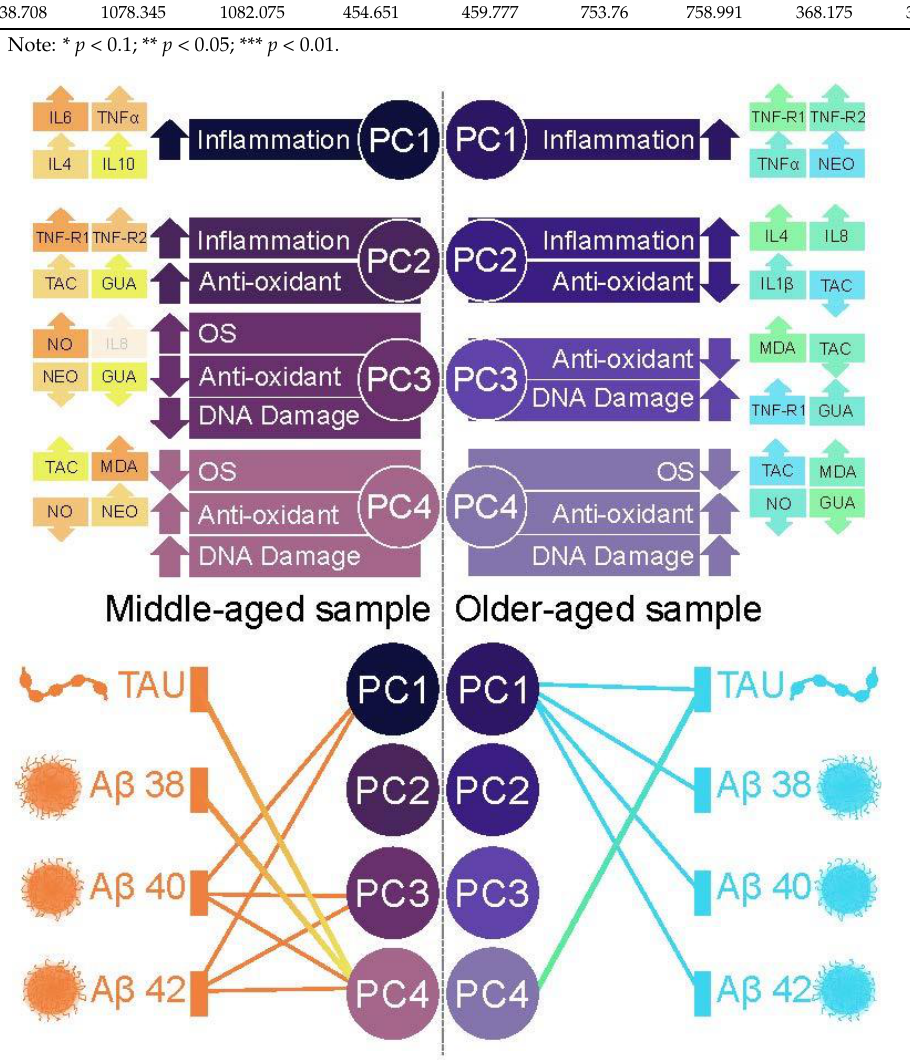
Figure 1. Top: Illustration of the identified inflammatory states (PC1–PC4) and their main contributing blood markers (inflammation: TNF- α , TNF-R1, TNF-R2, IL1- β , IL4, IL6, IL8, IL10; Oxidative Stress: NO, NEO; Anti-oxidant: TAC; DNA damage: GUA, MDA) in middle-age ( left ) and older-age ( right ) participants. Bottom: Significant associations (Bonferroni-corrected) between the identified inflammatory states (PC1 – PC4) and AD biomarkers in middle-age ( left ) and older-age ( right ) participants.